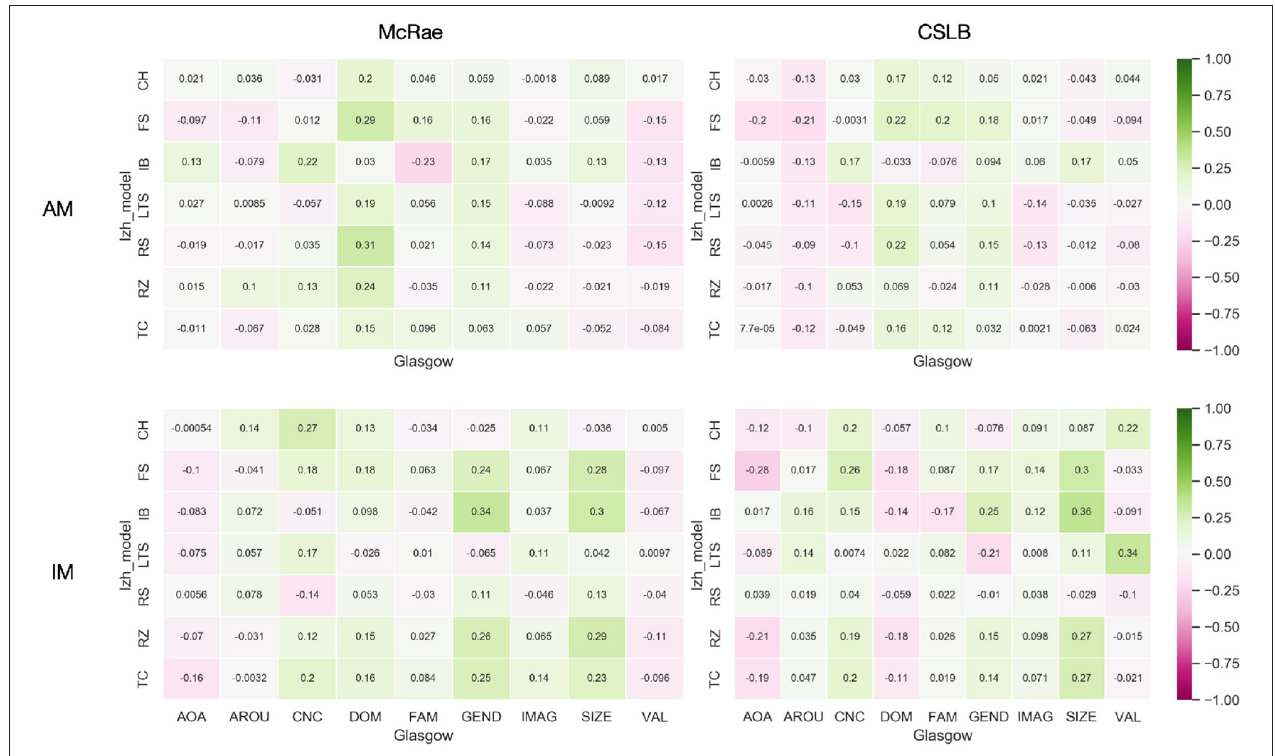
FIGURE 5 | The heatmap of generality analysis results.